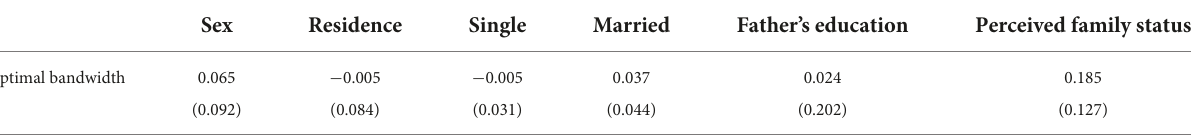
TABLE 8 Continuity test for control